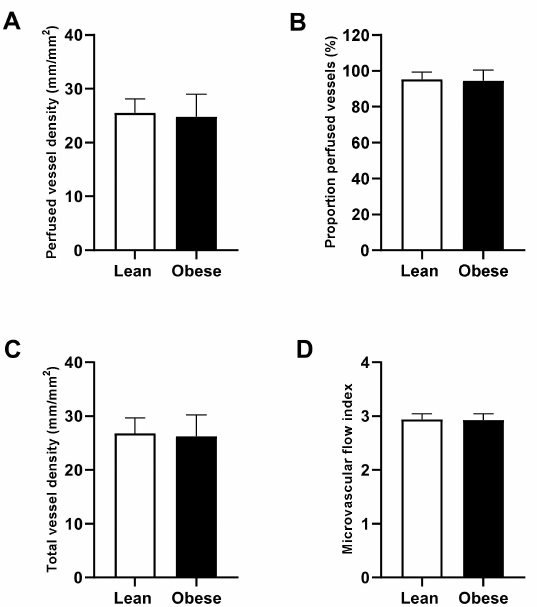
Figure 3. Preoperative microcirculatory perfusion. Perfused vessel density ( A ), total vessel density ( B ), proportion of perfused vessels ( C ), and microvascular flow index ( D ) measured one day before surgery in lean (open bars) and obese (black bars) patients. Data are represented by mean ± SD and tested with a student t -test.